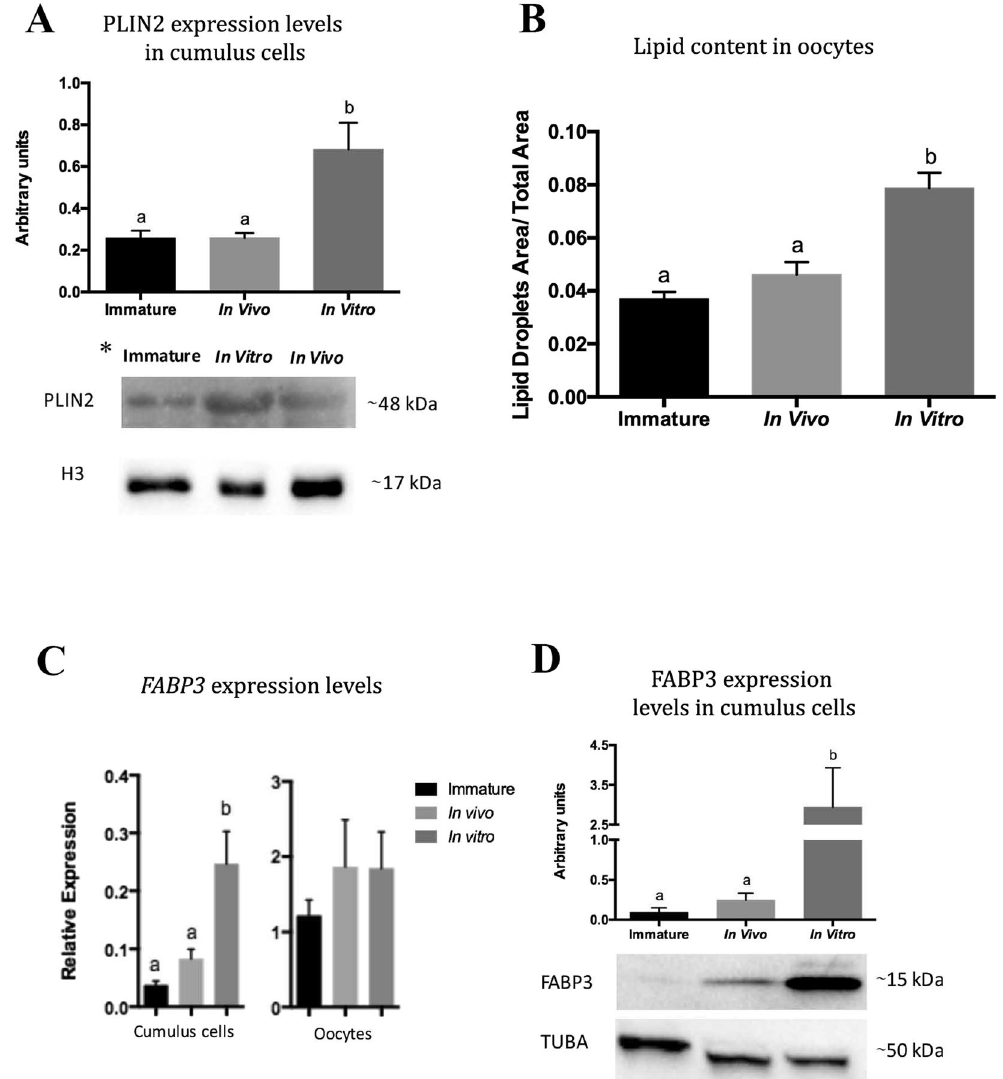
Figure 1. Quantification of lipid content in cumulus cells and oocytes derived from immature, in vivo -matured and in vitro -matured cumulus-oocyte complexes (COCs). ( A ) Lipid content in cumulus cells was determined by western blot analysis of perilipin 2 (PLIN2) using histone 3 (H3) as a normalizer. ( B ) Lipid quantification in oocytes was performed by fluorescence confocal microscopy of lipid droplets. The values for lipid content represent the ratio of area of lipid droplets to total oocyte area. Representative immature, in vivo -matured and in vitro -matured oocytes stained with BODIPY 493/503 are shown in Supplementary Fig. S1. ( C ) Relative amounts of fatty acid binding protein 3 ( FABP3) transcripts in immature, in vivo -, and in vitro - matured cumulus cells and oocytes. ( D ) FABP3 protein levels in cumulus cells normalized by x-Tubulin (TUBA). Lowercase letters above bars in the same graph indicate significant differences ( P < 0.05). Values are presented as mean ± standard error of the mean. The full western blot images in ( A ) and ( D ) are shown in Supplementary Fig. S2a and S2b, respectively. * The order of the groups is different between the graph and the representative immunoblot